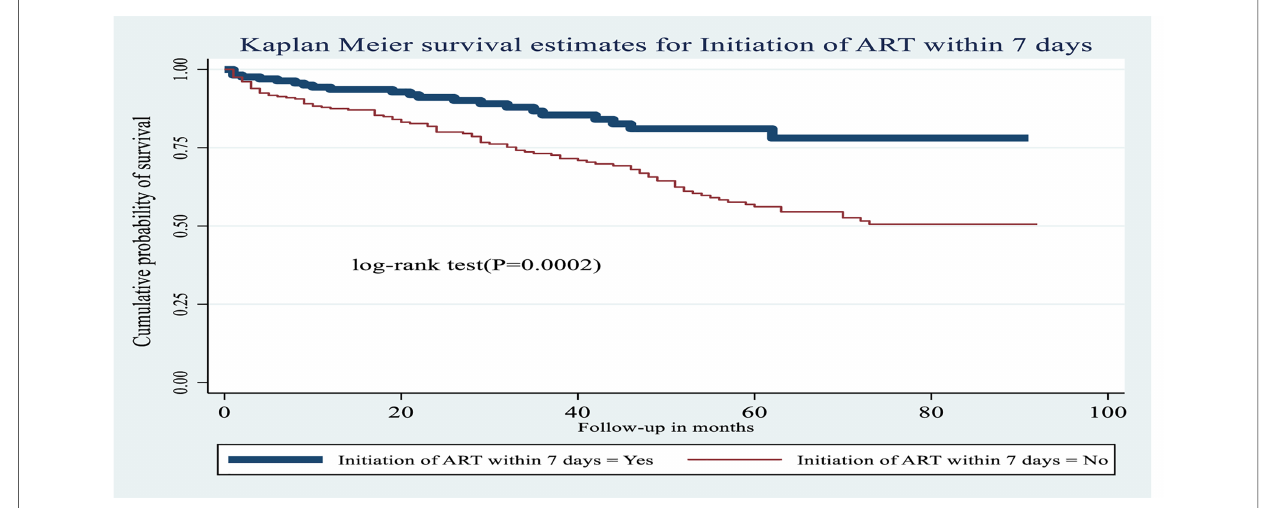
FIGURE 8 Kaplan – Meier estimates of probability of OI-free survival by ART initiation time among HIV-infected children receiving ART at Amhara regional state comprehensive specialized hospitals, Ethiopia,